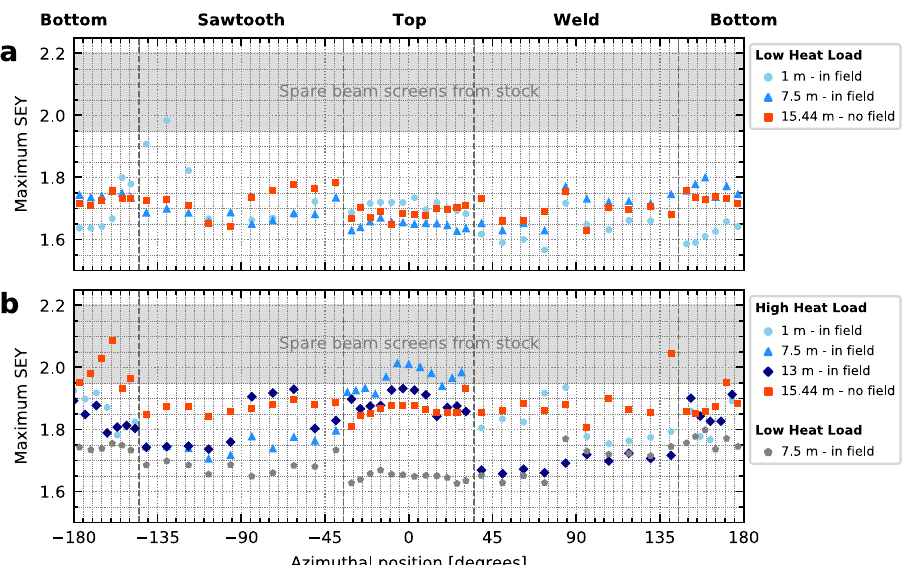
Fig. 3 Azimuthal pro fi les of maximum secondary electron yield (SEY). Maximum SEY as a function of the azimuthal position for sections at different longitudinal positions represented by the different colours (see Fig. 2) along V1 beam screens from a Low Heat Load and b High Heat Load LHC dipoles, collected both in fi eld and fi eld-free regions. In ( b ), a maximum SEY pro fi le from Low Heat Load beam screen is added for comparison. The range of maximum SEY measured on spare beam screens from the stock is indicated by the grey background as a reference.